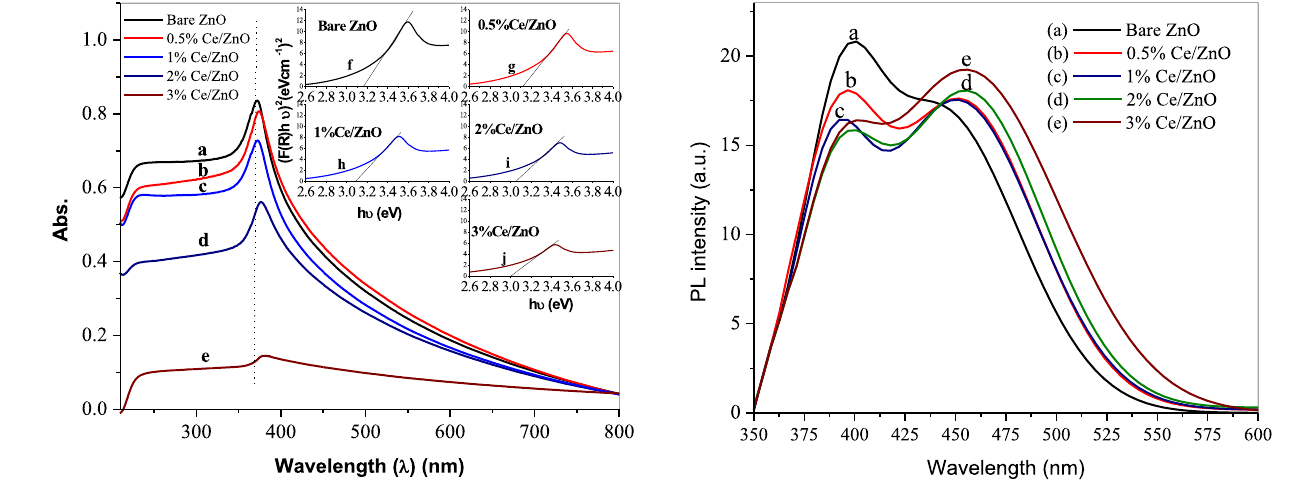
Fig. 6 PL spectra of a bare ZnO, b 0.5%Ce/ZnO, c 1%Ce/ZnO, d 2%Ce/ZnO and e